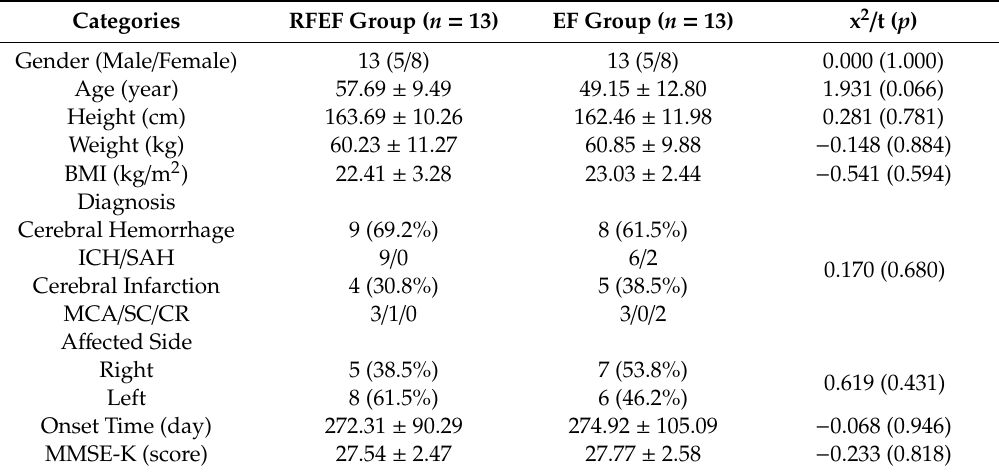
Table 1. General characteristics of the subjects ( N =